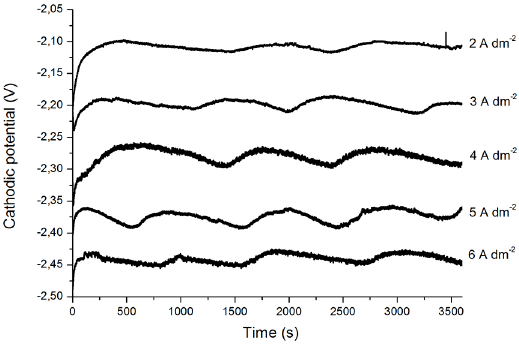
Figure 1. Chronopotentiometric monitoring for the galvanostatic deposition of the Co-Ni / SiC composite on carbon